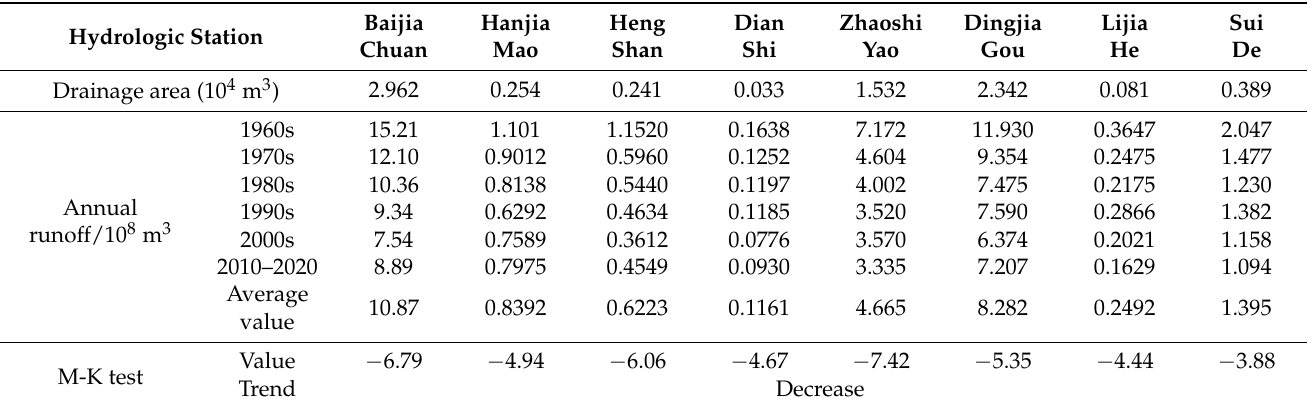
Table 1. Runoff values and variation trends (M–K test values) at the eight gauging stations in the Wuding River basin.